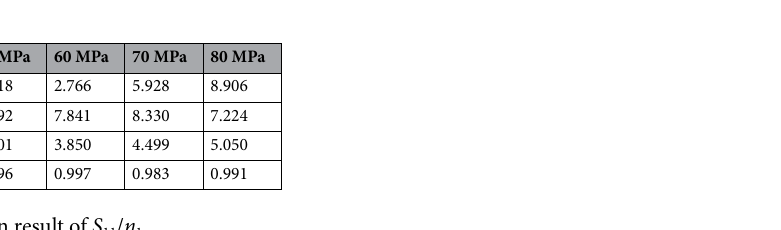
Table 3. Calculation result of S 11 / η 1